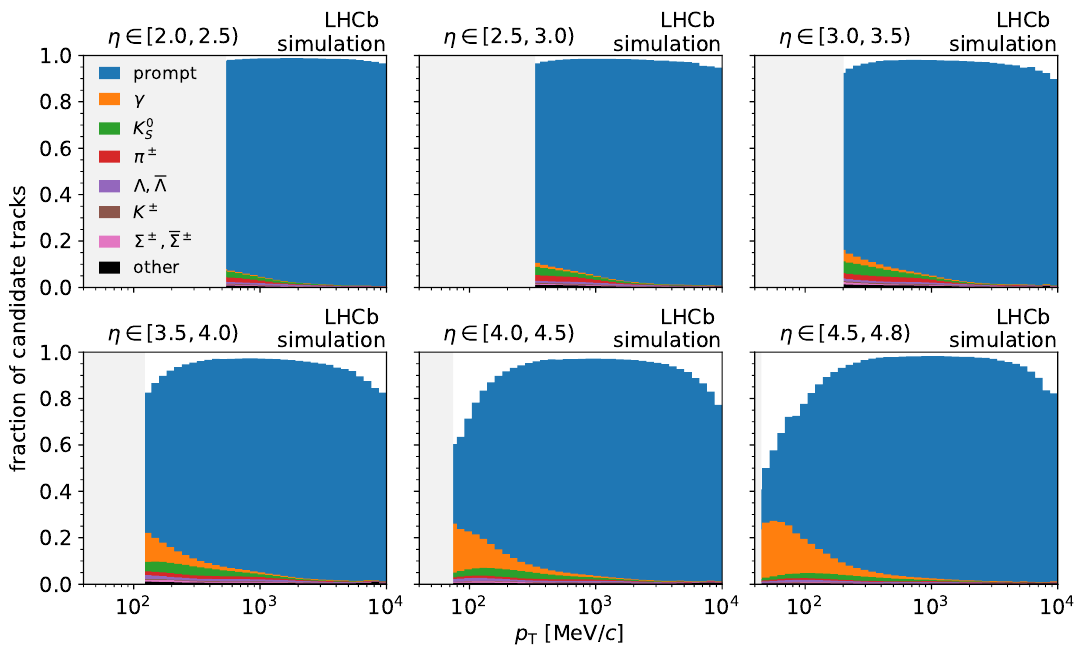
Figure 3 . Origins of the candidate tracks in intervals of η and as a function of p T for the simulated sample generated with the magnetic field pointing upwards. The prompt category refers to the signal tracks, while the other categories correspond to non-prompt tracks originating from the listed parent particles and include both decays and material interactions. Fake tracks are indicated by the white areas above the stacked histograms. The light-grey areas represent the limit of the kinematic